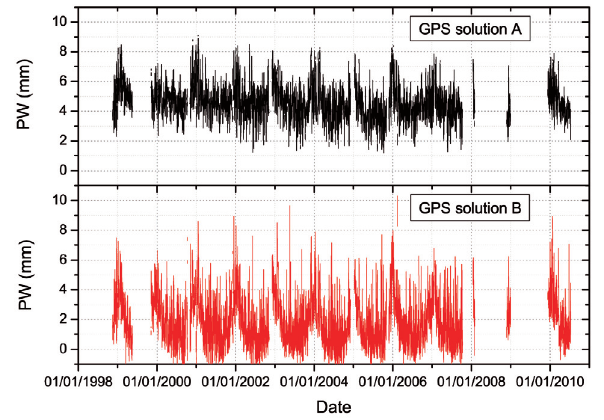
Figure 7. Precipitable water time series obtained from solution A (top) and B (bottom). The presence of negative values in the series of solution B is discussed in the main text.